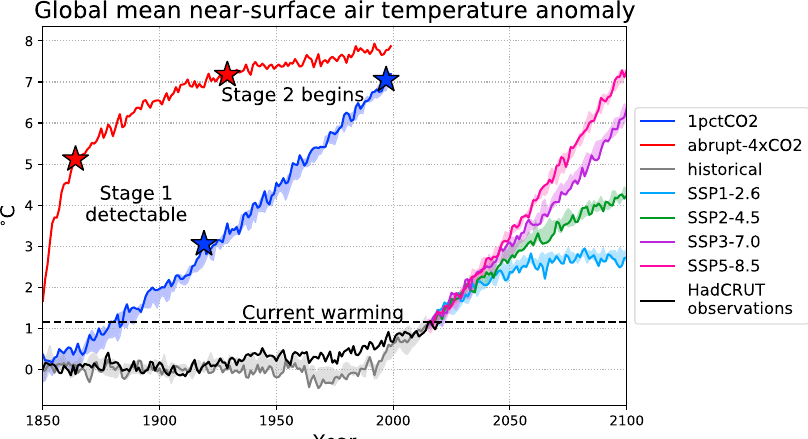
Fig. 8 Global mean near-surface air temperature anomaly in different CMIP6 scenarios as simulated by UKESM. Timeseries are annually averaged and shown as anomalies relative to the piControl mean over the last 150 years of simulation. The historical simulation (1850 – 2014) branches into four SSPs (Shared Socioeconomic Pathways; 2015 – 2100) as examples of possible future climate change trajectories. The idealised simulations (1pctCO2 and abrupt- 4xCO2) are indexed from 1850 – 1999 for convenience, but do not correspond to any historical forcing. For each scenario, the fi rst ensemble member is shown with a darker line, while the range of four ensemble members is shown with lighter shading (except for abrupt-4xCO2 where only one ensemble member ran the experiment). Stars show the beginning of Stages 1 and 2 as simulated by this study, for the 1pctCO2 and abrupt-4xCO2 cases. Also shown is the observed global mean near-surface air temperature anomaly from the HadCRUT.4.6.0.0 dataset 56 , relative to 1850. The dashed line shows the current level of warming, i.e. the HadCRUT observations for